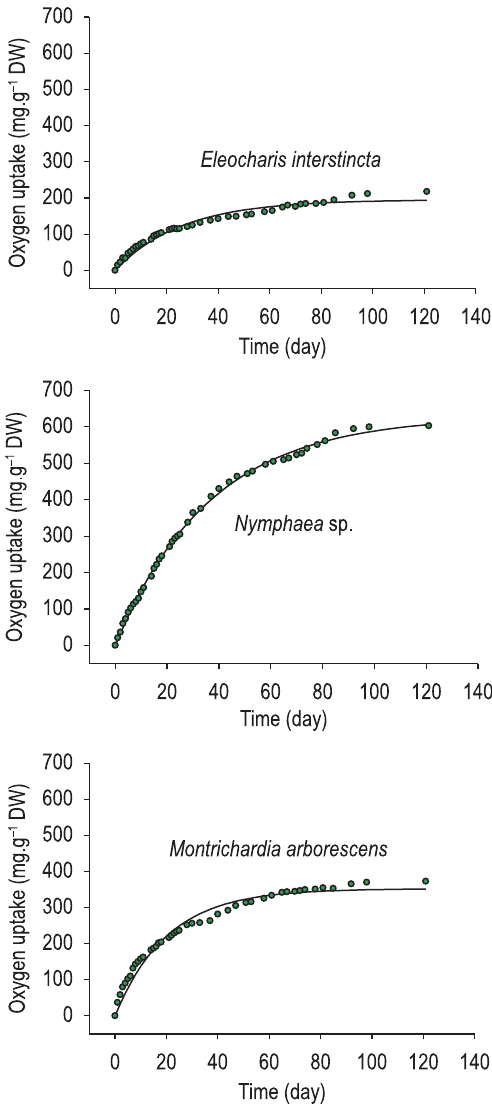
Figure 1. Oxygen uptake kinetics during aerobic decomposition of E. interstincta , Nymphaea sp. and M. arborescens